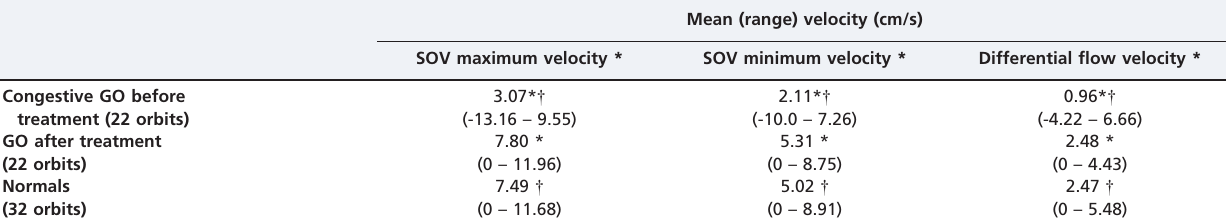
Table 2 - Comparison of blood flow parameters in the superior ophthalmic vein (SOV) in patients with Graves’ orbitopathy and